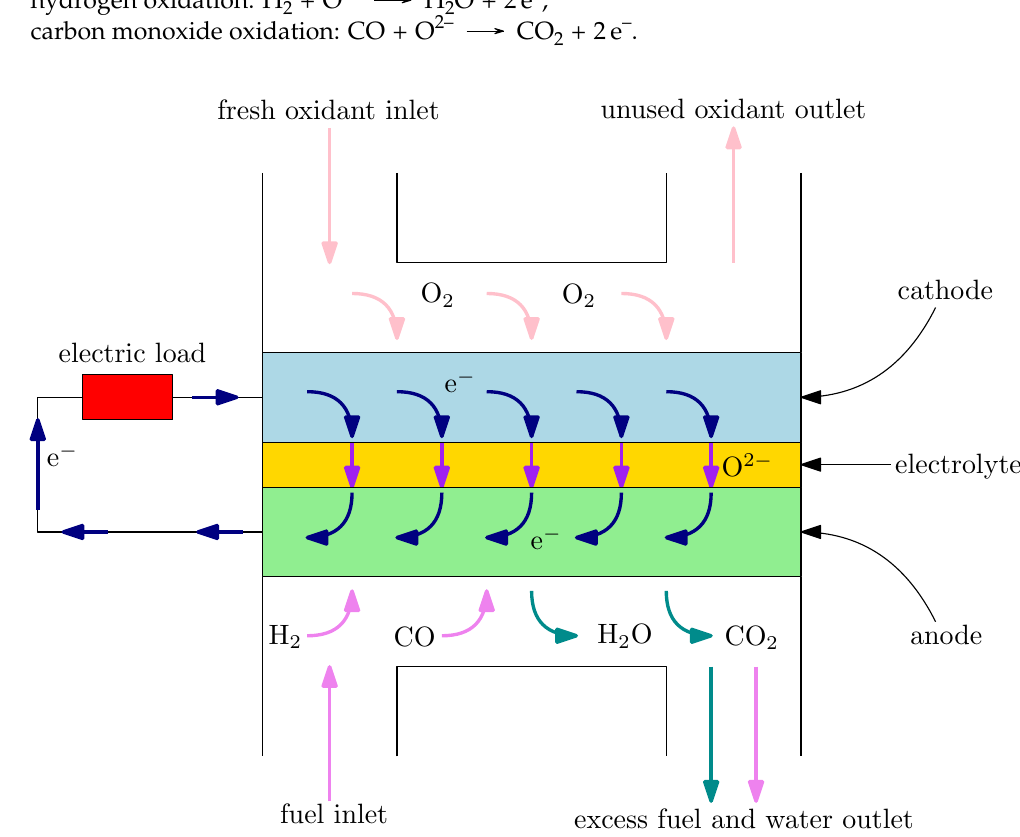
Figure 1. Principle of the solid oxide fuel cell